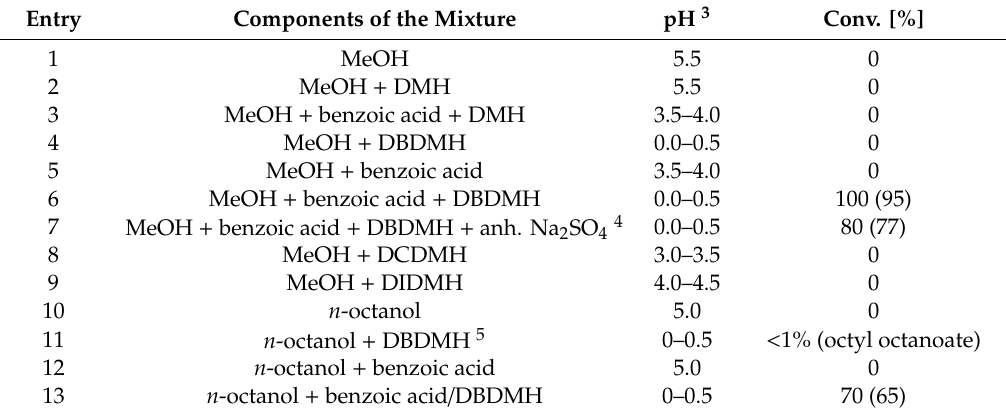
Figure 3. Timeline of the 1 H-NMR spectra and pH measurements for esterification of benzoic acid with methanol. Table 2. pH measurements and conversion percentages of control esterification reactions 1,2